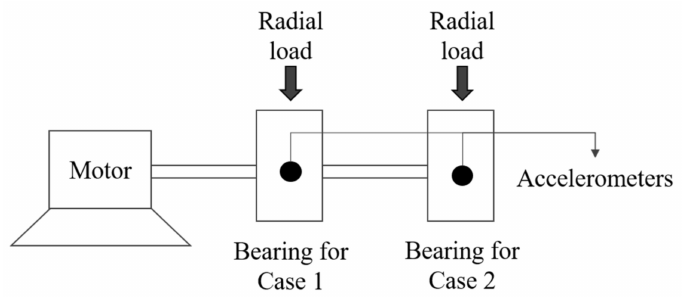
Figure 2. Schematic of experimental setup in cases 1 and